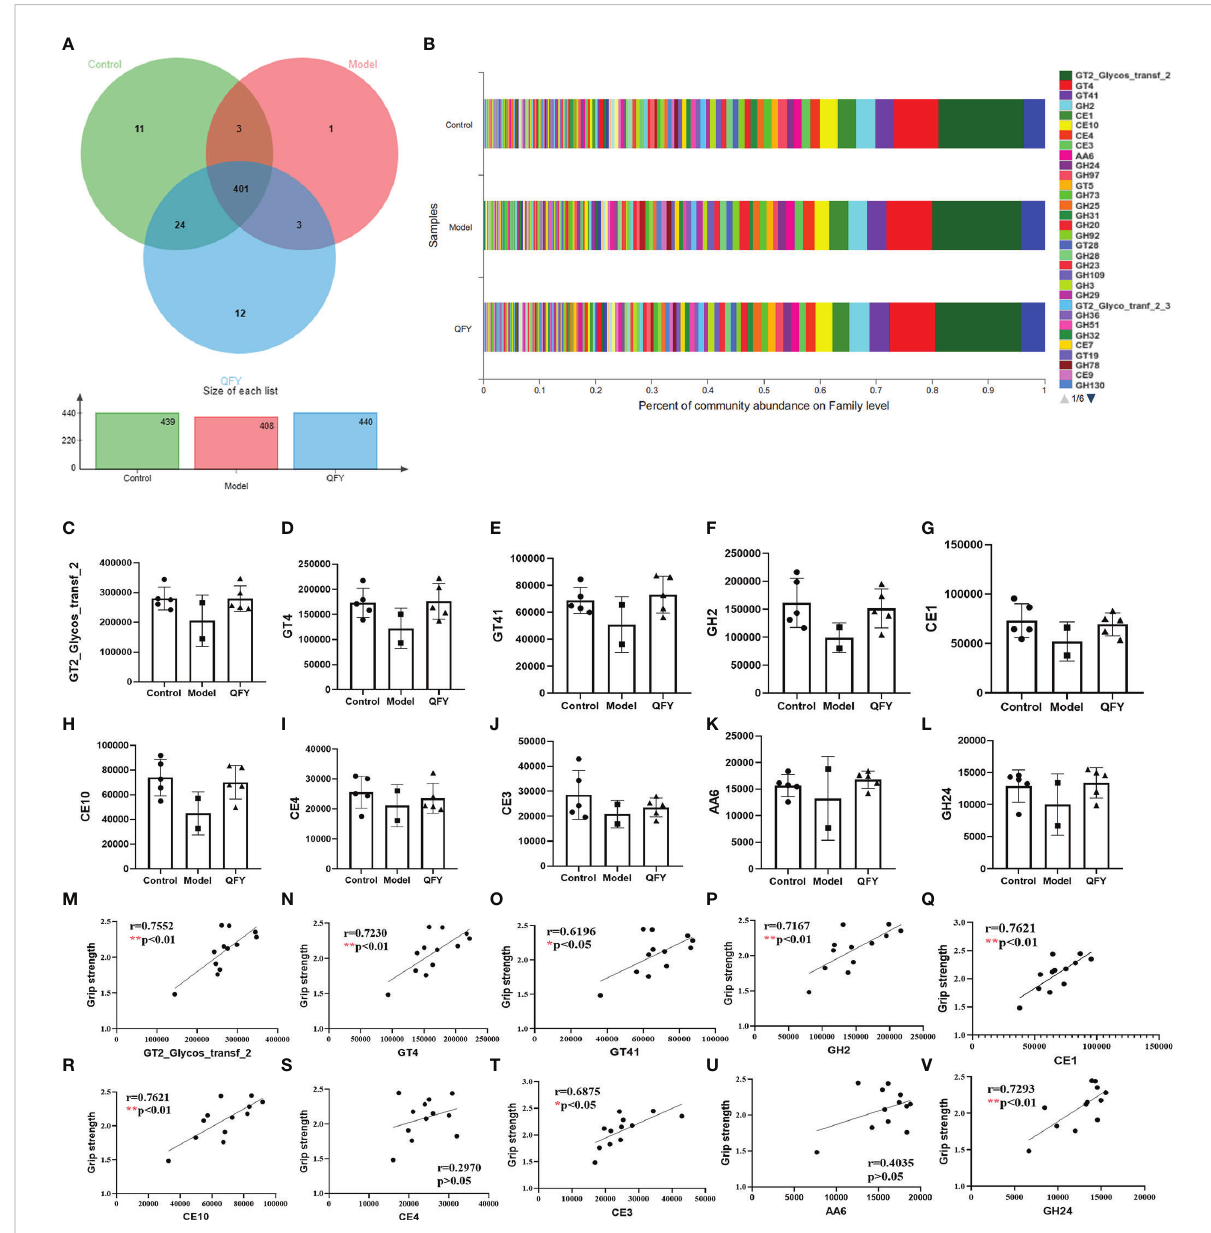
FIGURE 9 The effect of Qi-Fu-Yin on the function of CAZy of intestinal microorganisms in APP/PS1 transgenic mice. (A) Functional pro fi les of each group in CAZy (family), (B) Percent of community abundance on family level, (C) GT2_Glycos_transf_2 (Glycosyl Transferases), (D) GT4 (Glycosyl Transferases), (E) GT41 (Glycosyl Transferases), (F) GH2 (Glycoside Hydrolases), (G) CE1 (Carbohydrate Esterases), (H) CE10 (Carbohydrate Esterases), (I) CE4 (Carbohydrate Esterases), (J) CE3 (Carbohydrate Esterases), (K) AA6 (Auxiliary Activities), (L) GH24 (Glycoside Hydrolases), (M) The correlation between grip strength and abundance of GT2_Glycos_transf_2, (N) The correlation between grip strength and abundance of GT4, (O) The correlation between grip strength and abundance of GT41, (P) The correlation between grip strength and abundance of GH2, (Q) The correlation between grip strength and abundance of CE1, (R) The correlation between grip strength and abundance of CE10, (S) The correlation between grip strength and abundance of CE4, (T) The correlation between grip strength and abundance of CE3, (U) The correlation between grip strength and abundance of AA6, (V) The correlation between grip strength and abundance of GH24. Mean ± SD, n=2~5, * P < 0.05, ** P < 0.01, unpaired Student ’ s- t test. GraphPad Prism 8.0.1